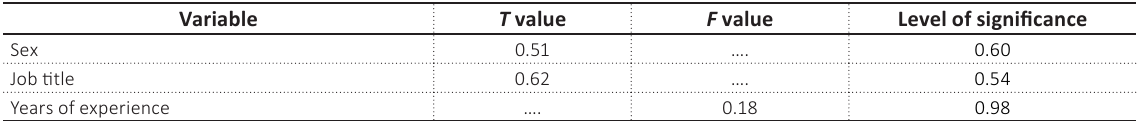
Table 7. The results of T values, F values, and the level of significance shown based on the demographic